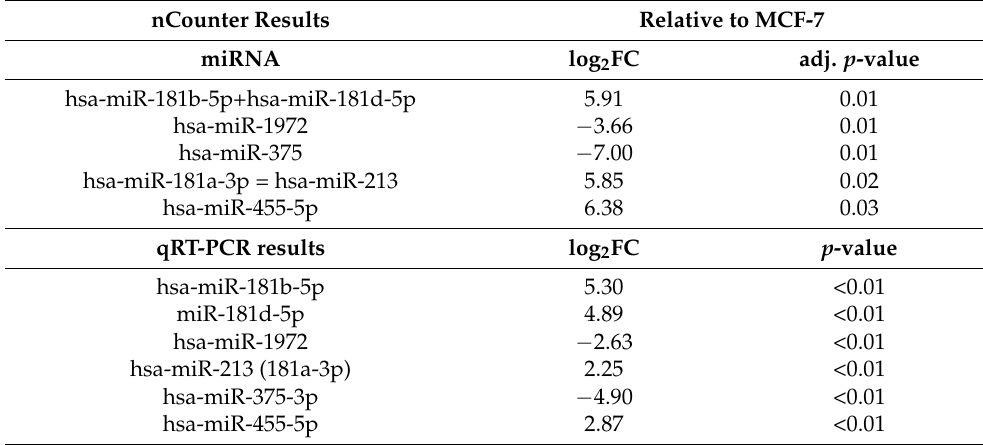
Table 2. nCounter data analysis showing significantly tamoxifen-regulated miRNAs and correspond- ing qRT-PCR data. Results of three independently generated MCF-7 TAM R cell lines were combined. For nCounter analysis, three independent RNAs were used each. For qPCR, each data-point repre- sents four independent